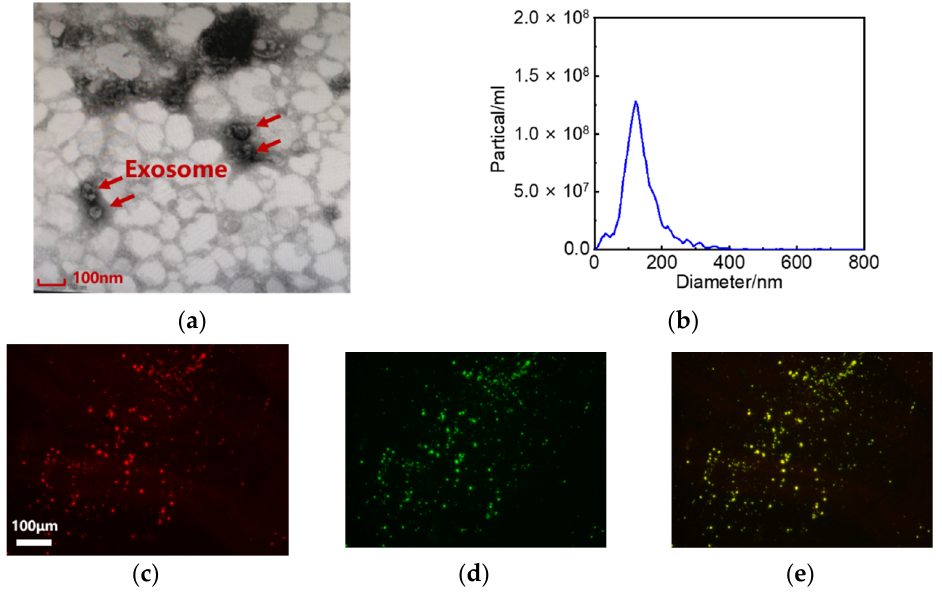
Figure 9. The characterization of exosome. ( a ) TEM image and ( b ) ZetaView analysis of the size distribution of extracted exosomes derived by H1395 cells; ( c ) Under 549 nm laser excitation, red fluorescence represents antibodies, ( d ) Under 488 nm laser excitation, green fluorescence represents exosomes, ( e ) Merged picture of ( c , d ).